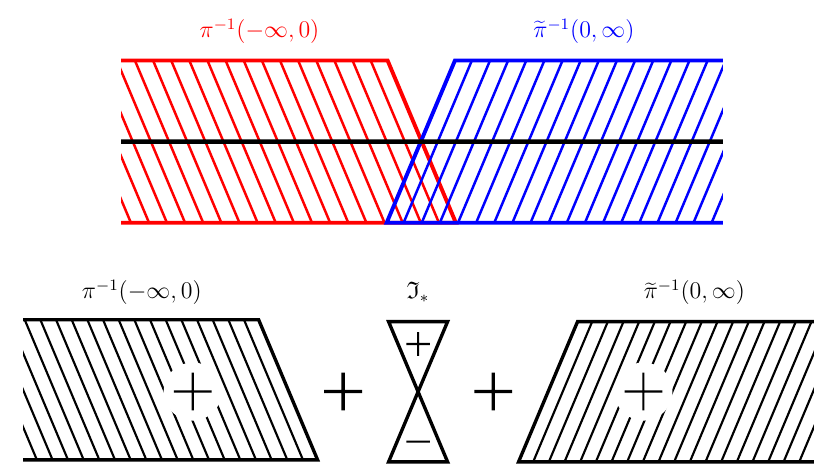
Figure 1 . A schematic depiction of the interpolation scheme for integrating over M . The hori- zontal axis represents the bosonic coordinate t while the vertical direction represents the fermionic coordinates ν a . Top: the mismatched fibers coming from the projections π (red, left) and right). Bottom: the splitting of the integration contour into integration over the fibers of π , the fibers of π , and the image of the interpolation map I e